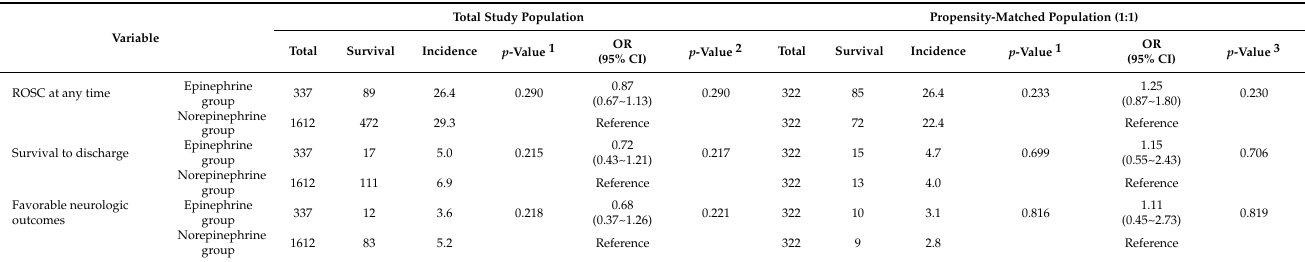
Table 2. The effects of prehospital epinephrine administration by EMS providers during OHCA on survival to discharge and favorable neurological